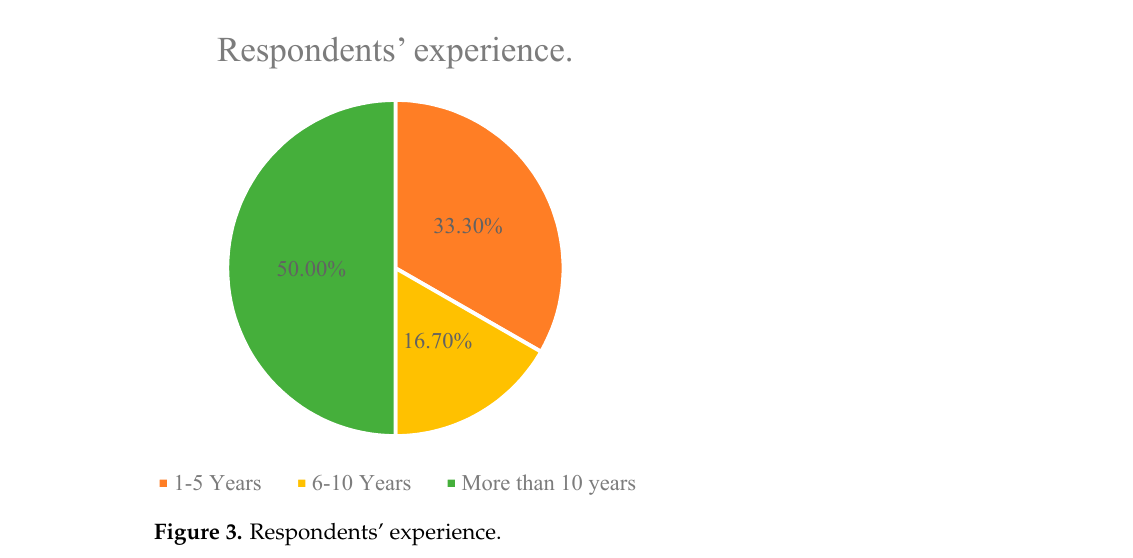
Figure 2. Respondents’ affiliation.